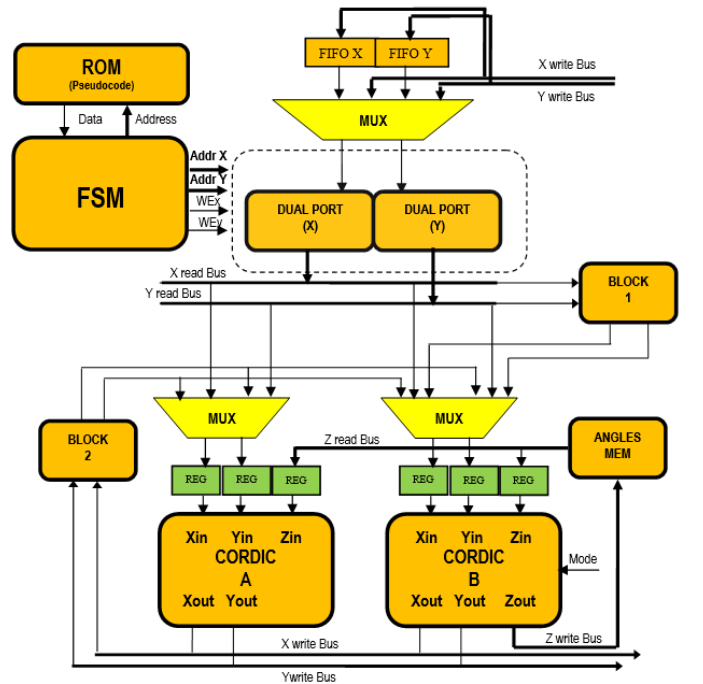
Figure 6. Systolic operating architecture for the decomposition of eigenvalues and